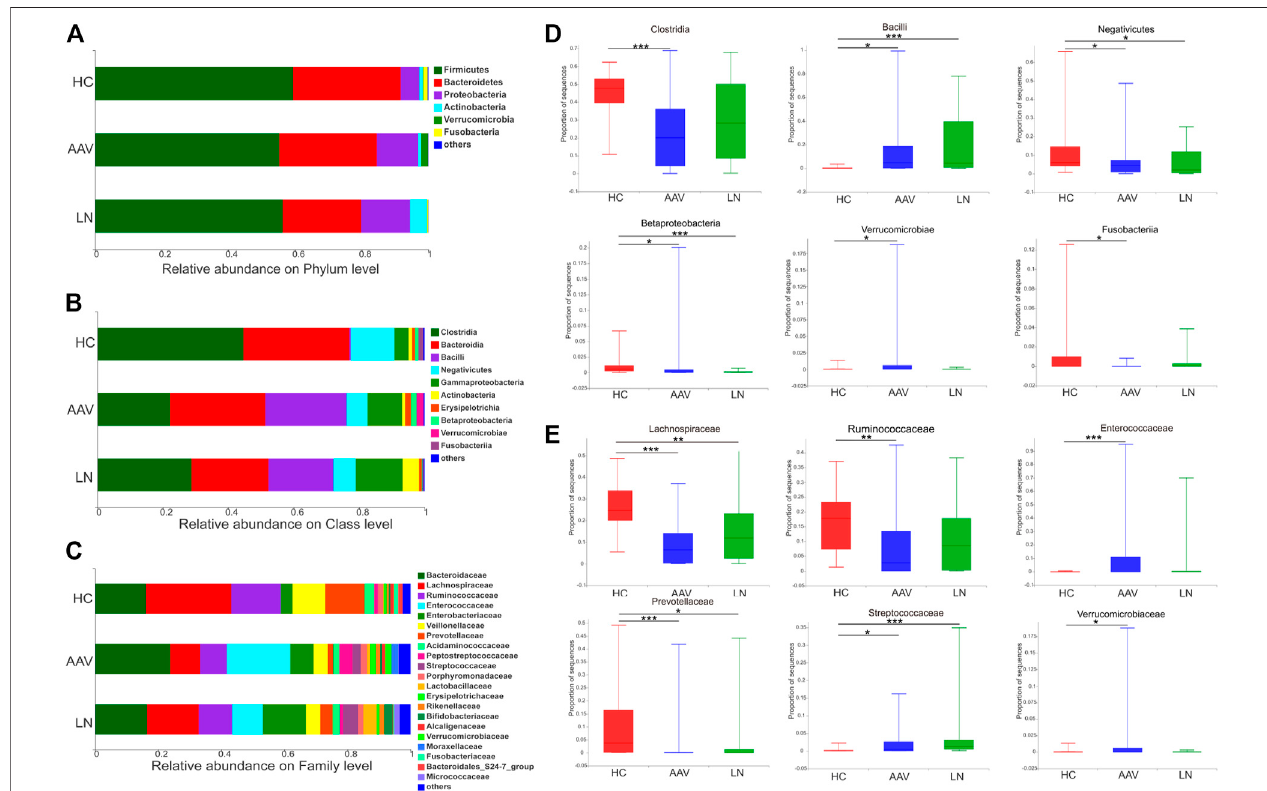
FIGURE 2 | Overview of the bacterial community composition in AAV patients, LN patients and healthy controls. (A – C) The relative abundances of sequences classi fi edto majortaxonomic phylum, classand family. (D,E) Relative abundanceofselectedtaxa amongAAV, LNand HC were compared.* p < 0.05; ** p < 0.01; *** p < 0.001. AAV, ANCA associated vasculitis; LN, lupus nephritis; HC, healthy controls.